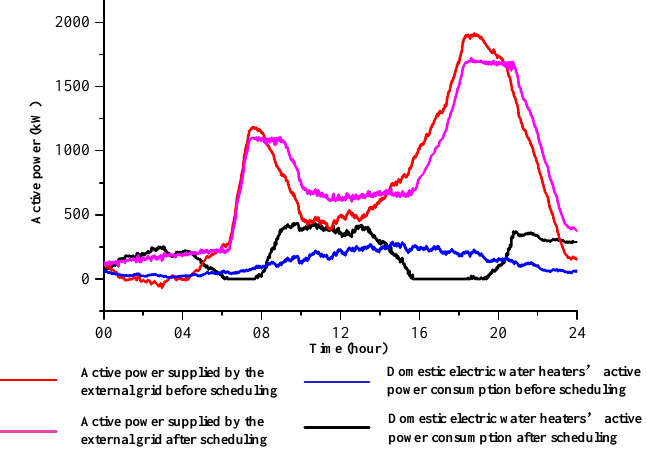
Energies 2017 , 10 , 1425 12 of 15